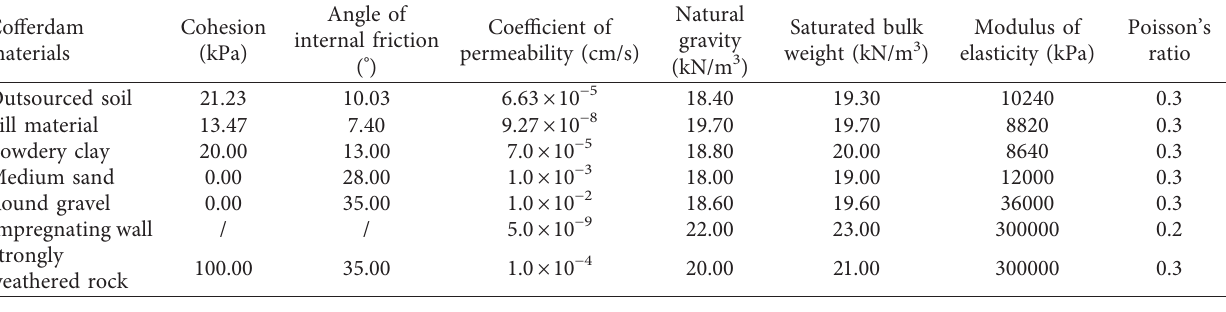
Table 1: Basic physical and mechanical parameters of cofferdam, rock, and